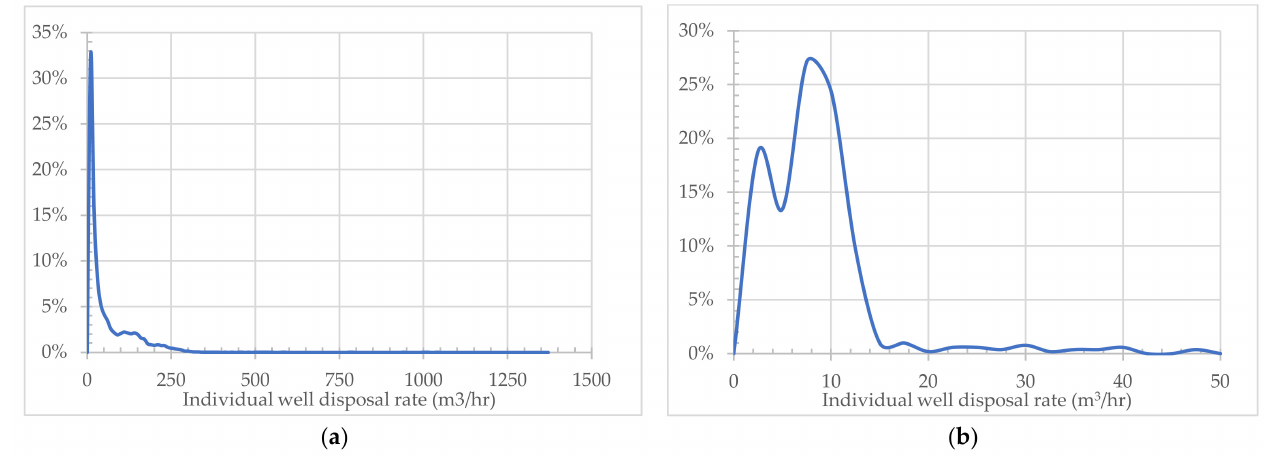
Figure A28. Historical per-well water injection rate ( X -axis) frequency ( Y -axis) distributions (January 1962–December 2022) in ( a ) the Leduc Formation; ( b ) the Duvernay Formation.